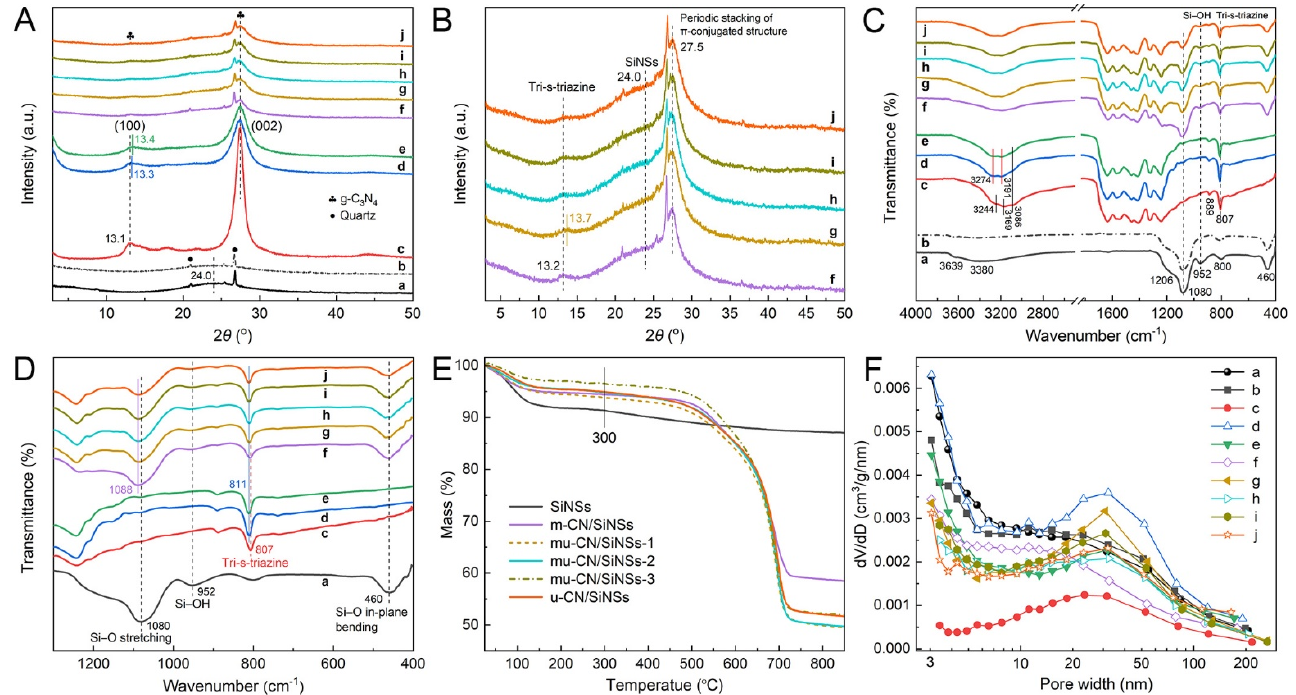
Figure 2. ( A ) Overall and ( B ) local enlarged XRD patterns; ( C ) overall and ( D ) local enlarged FTIR spectra; ( E ) TG curves; and ( F ) BJH pore-size distribution curves of ( a ) SiNSs, ( b ) SiNSs-550, ( c ) m-CN, ( d ) mu-CN, ( e ) u-CN, ( f ) m-CN/SiNSs, ( g ) mu-CN/SiNSs-1, ( h ) mu-CN/SiNSs-2, ( i ) mu-CN/SiNSs-3, and ( j ) u-CN/SiNSs.